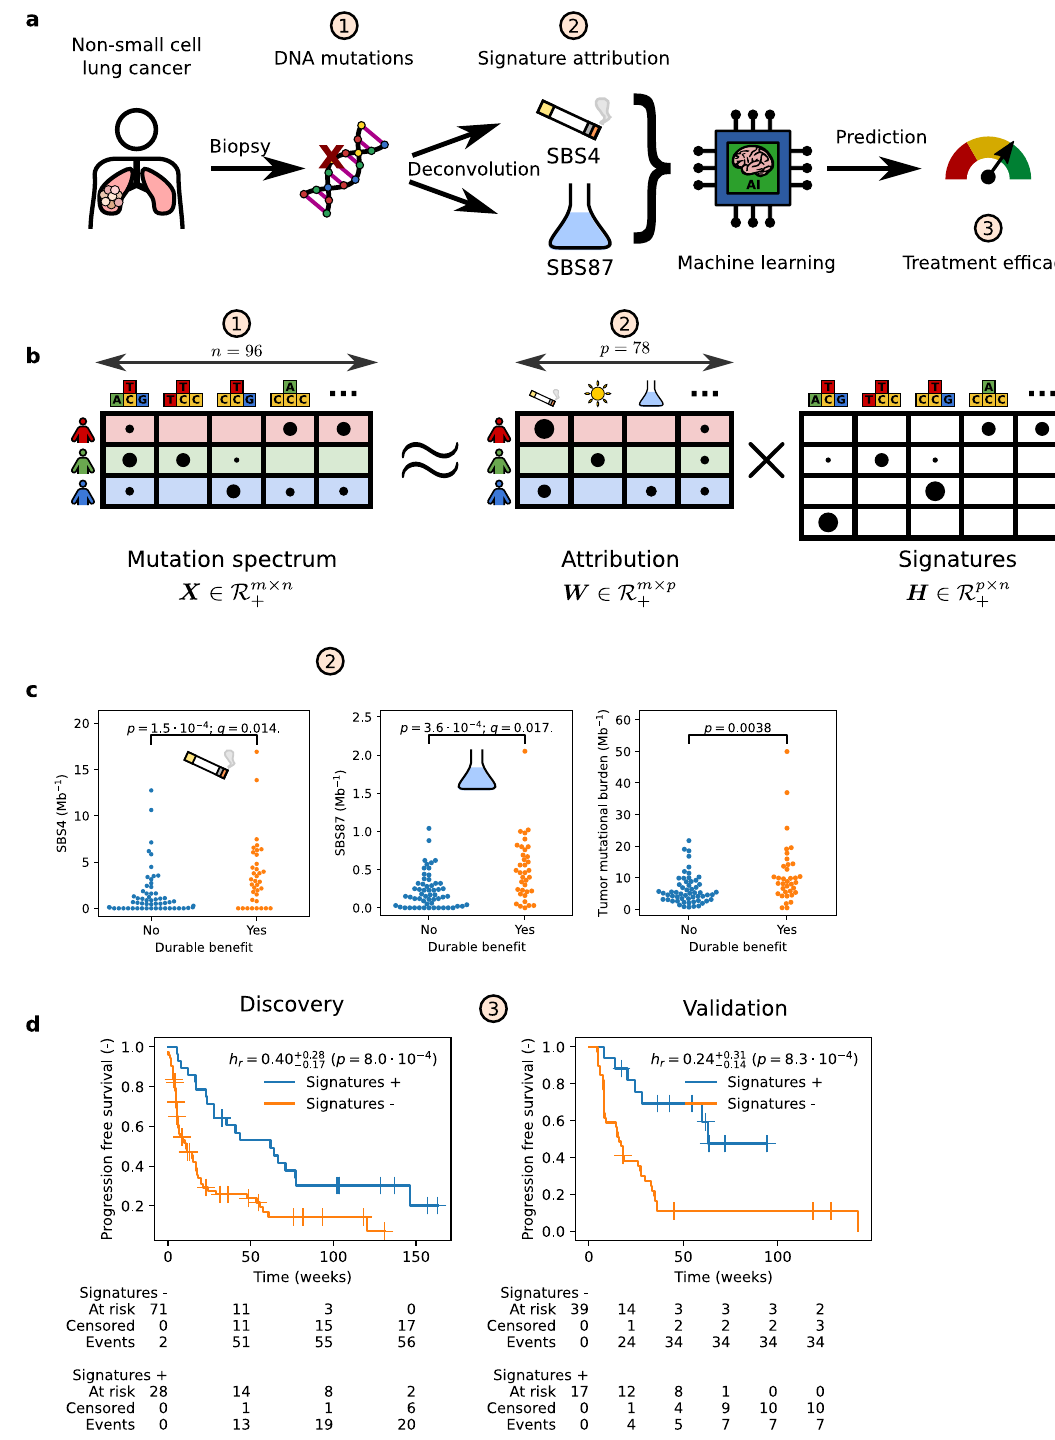
Figure 1. Mutational signatures from pre-treatment tumor tissue predict immunotherapy efficacy in advanced non-small cell lung cancer. ( a ), Single base substitutions (SBS) are determined from pre-immunotherapy tumor material. After deconvolution into signature attributions, a machine learning classifier uses smoking-associated signature SBS4 and thiopurine chemotherapy-associated signature SBS87 to predict durable benefit (DB) from immunotherapy. ( b ), Cartoon illustration of SBS signature deconvolution, W X ≈ WH X H where we solve for signature attribution given mutation spectrum and COSMIC signatures through . Nucleotide pyramids indicate SBS with flanking context; Sun, cigarette, and Erlenmeyer symbols depict example aetiologies; Shading highlights information that pertains to the corresponding patient. For illustration purposes, the size of the dots do not represent actual data. 0.014 0.017 ( c ) Signatures SBS4 [ q = , Benjamini–Hochberg corrected Kolmogorov–Smirnov (B–HK–S) test] and SBS87 ( q = , B-HK-S test) are linked to DB (discovery set). For reference, tumor mutational burden is also shown. ( d ) Patients predicted to have DB (Signatures +, blue line) have superior progression-free survival compared to those predicted to have non-DB (Signatures -, orange line) in the discovery set (left panel). The classifier’s performance replicates in an independent validation set (right). Censored observations are indicated by crosses. Estimates and corresponding 95% confidence intervals are indicated by sub and